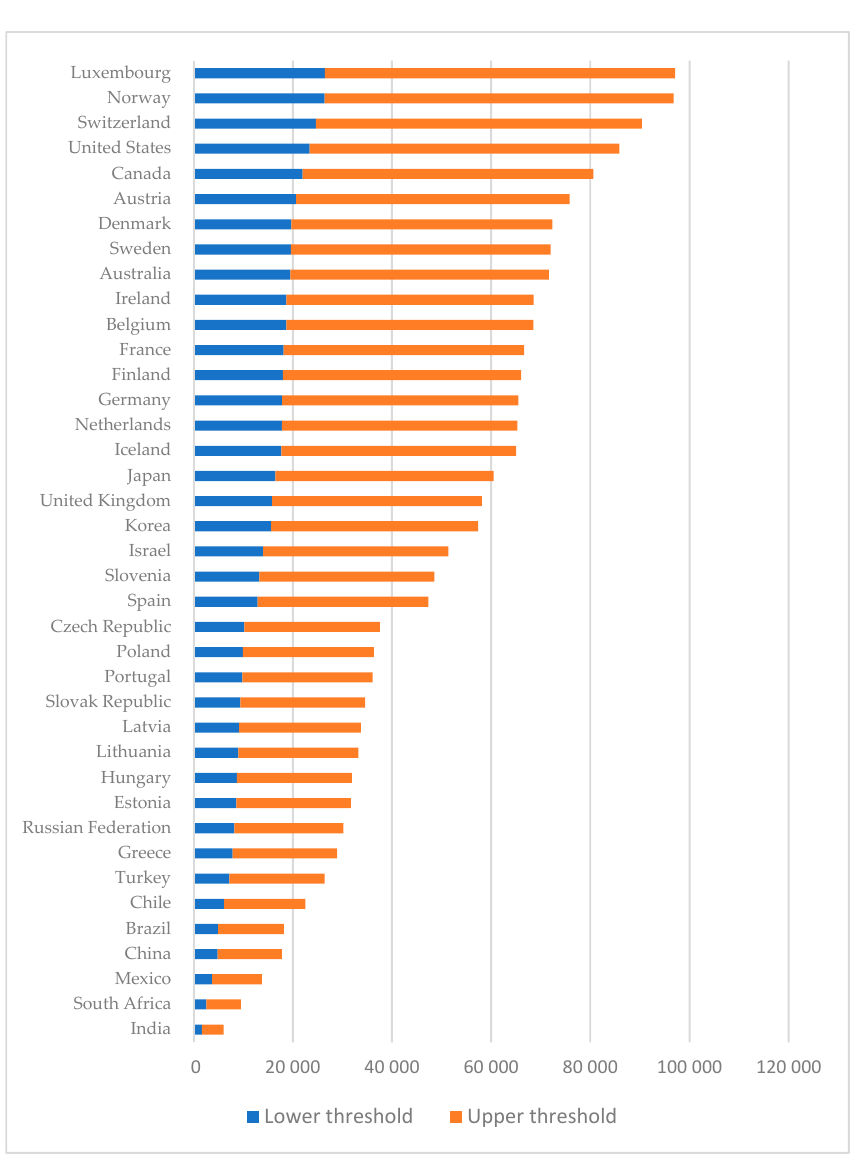
Figure 1. Middle-income thresholds in OECD countries and selected emerging economies. Note: Middle-classes and median incomes are defined relative to equivalised household disposable income. The middle-income class comprises individuals in households with incomes of between 75% and 200% of the median [6].